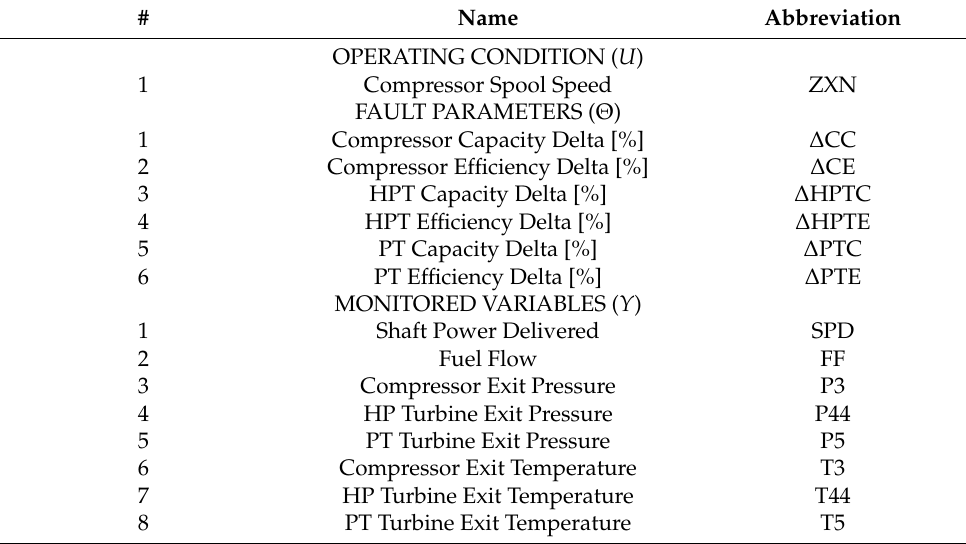
Table 1. Turbo shaft simulated